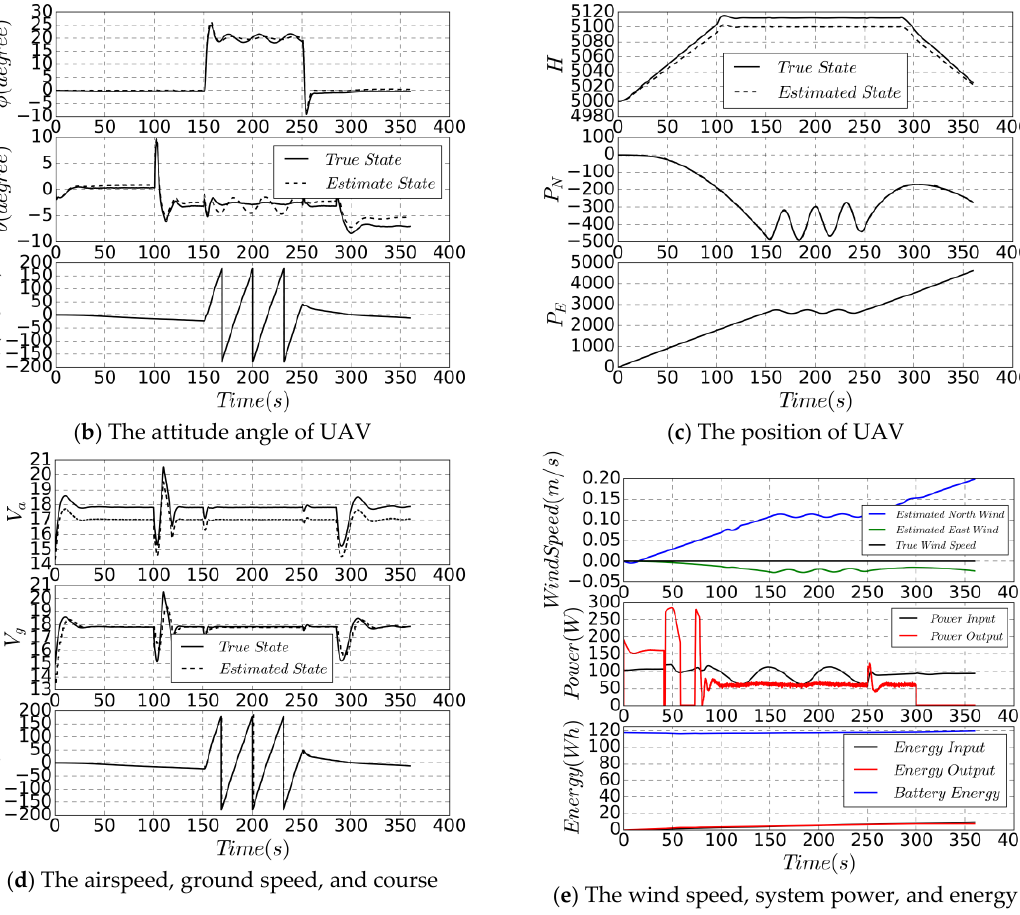
Figure 11. Complete mission process simulation.